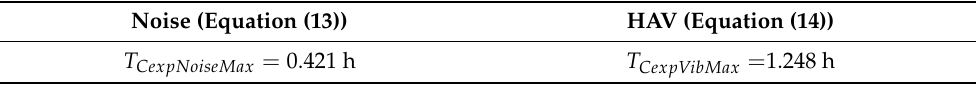
Table 4. Maximum exposure times for noise and vibration taken